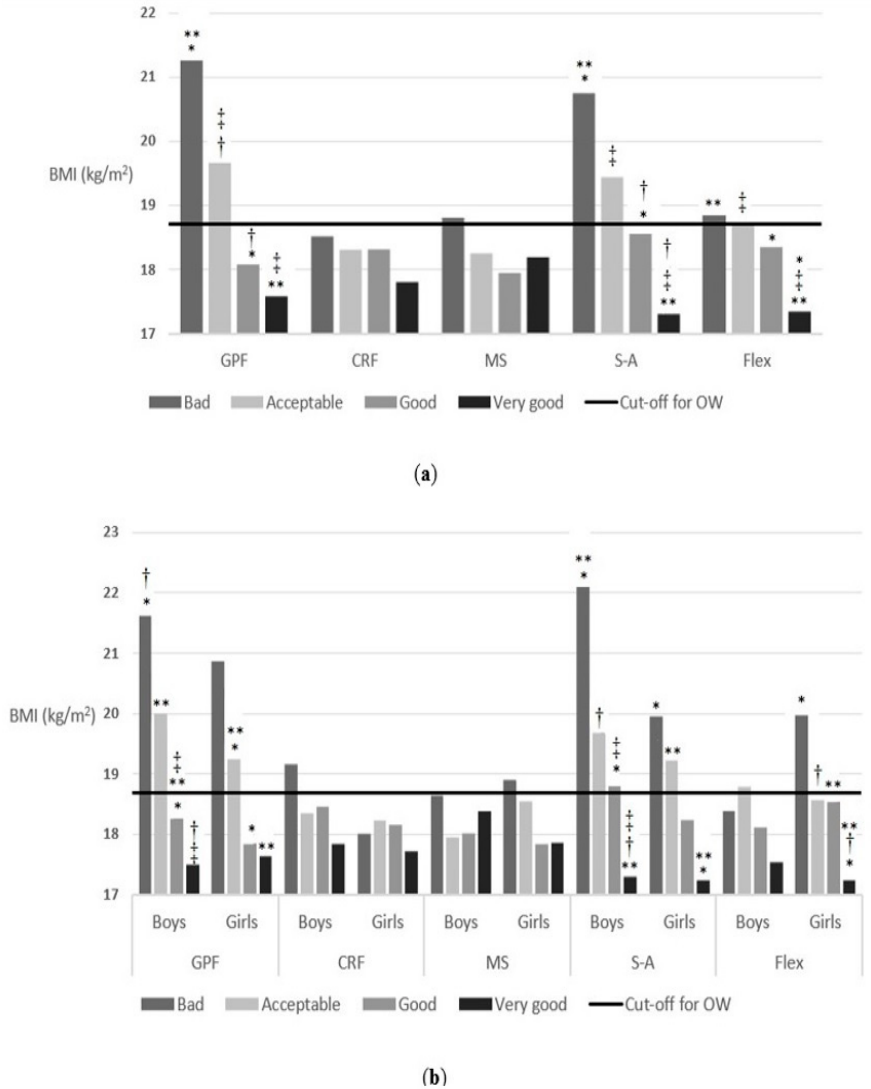
Figure 4. ( a ) Association between self ‐ reported physical fitness and body weight status (children reported); ( b ) Association between self ‐ reported physical fitness and body weight status (children reported) segmenting by sex. The cut ‐ off for OW line indicates the beginning of the OW category according to Cole’s cut ‐ off points [44]. * p ‐ value < 0.05, ** p ‐ value < 0.05, † p ‐ value < 0.05 and ‡ p ‐ value < 0.05. Abbreviations: CRF, cardiorespiratory fitness; Flex, flexibility; GPF, general physical fitness; MS, muscular strength; S ‐ A, speed ‐ agility.